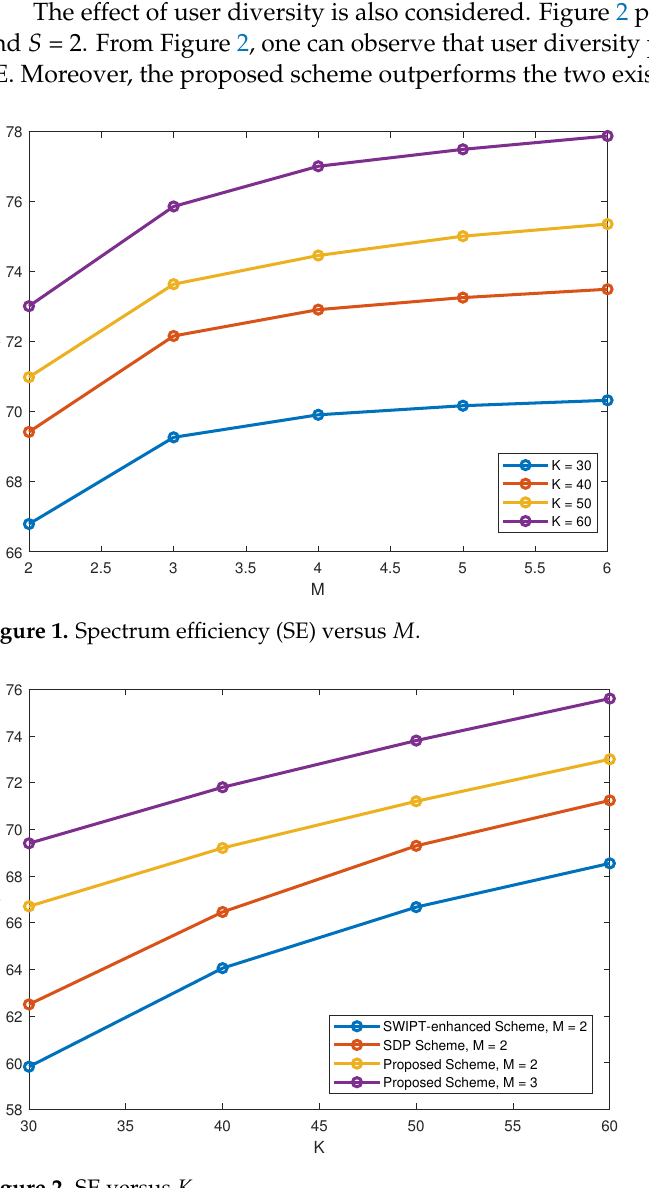
Figure 2. SE versus K